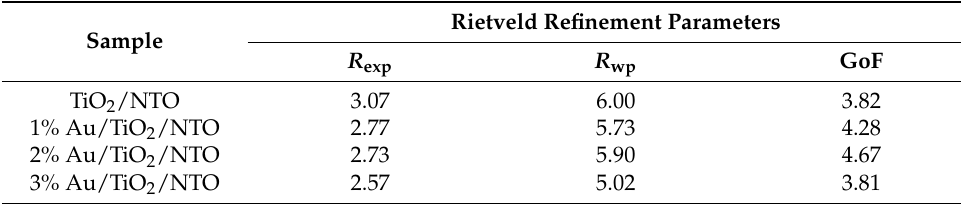
Table 1. Comparison of various composites of Na 2 Ti 6 O 13 and their applications.